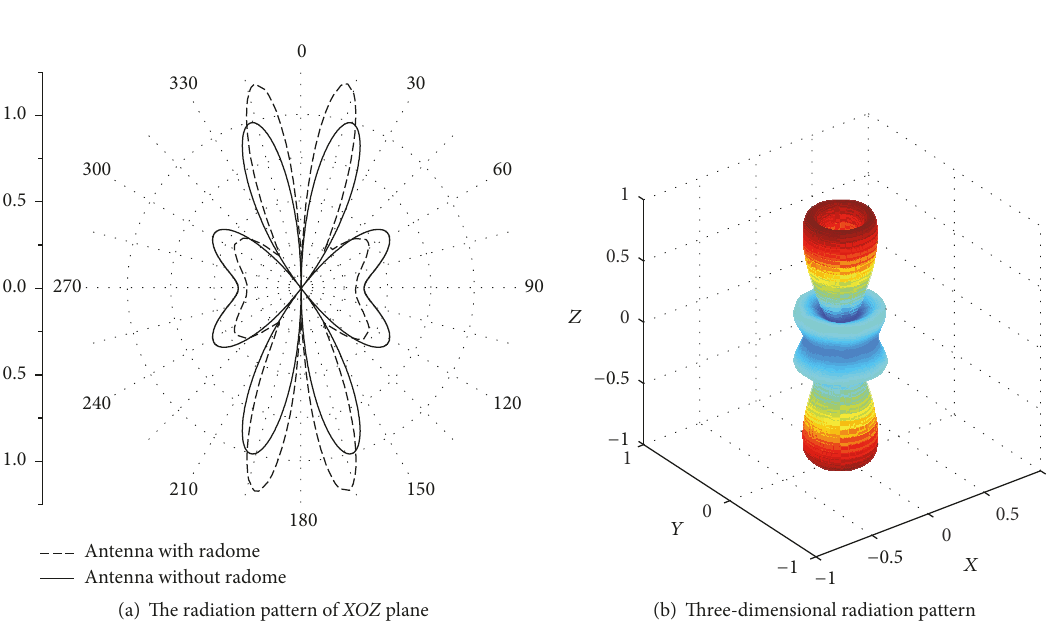
Figure 8: The radiation pattern of circular antenna with radome.